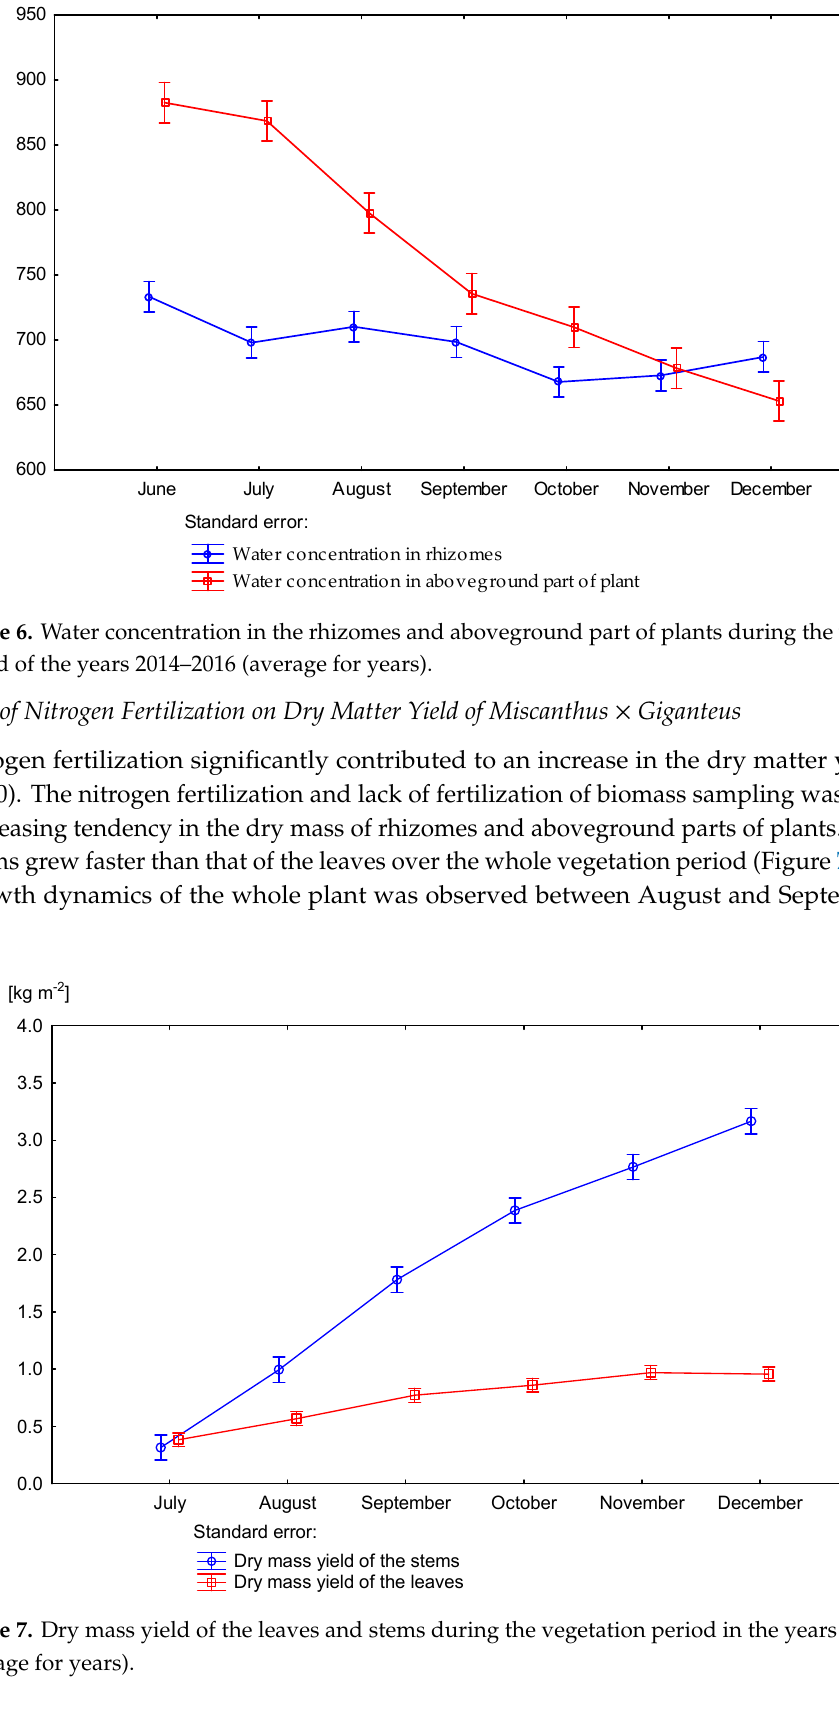
Figure 7. Dry mass yield of the leaves and stems during the vegetation period in the years 2014–2016 (average for years).